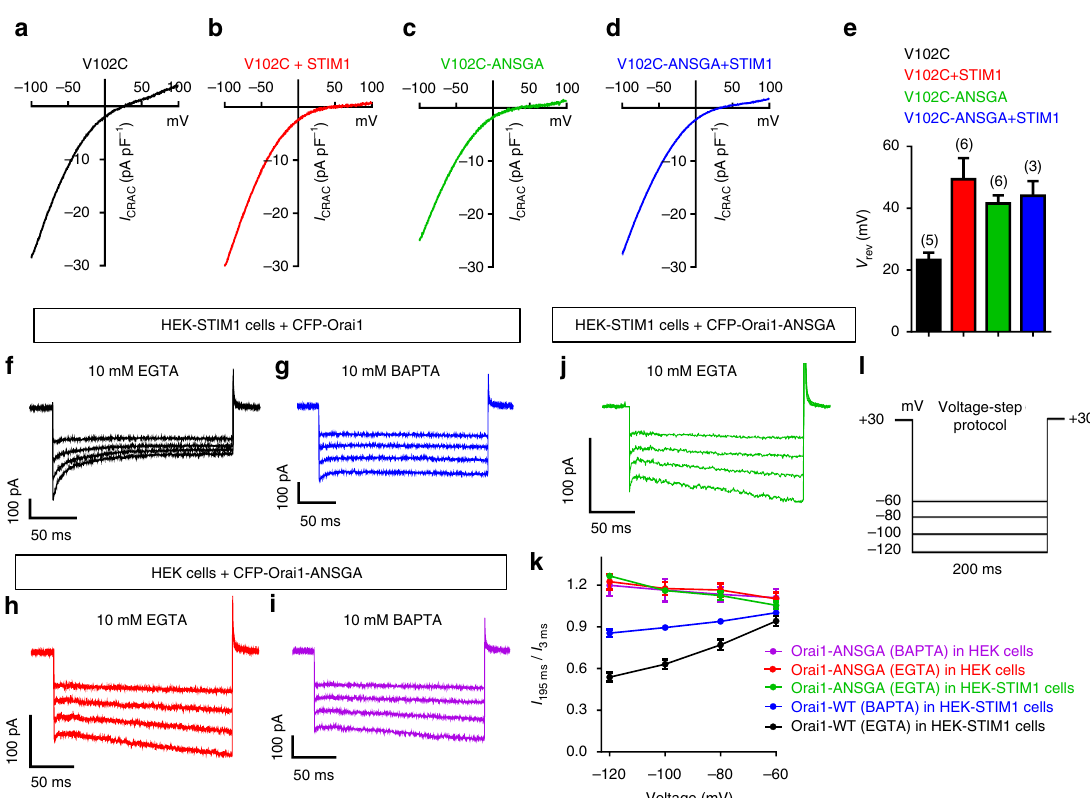
Figure 7 | The Orai-ANSGA mutation restores ion selectivity to the Orai1-V102C mutant and exhibits no CDI. ( a ) Current–voltage relationship for Orai1- V102C expressed in HEK cells (without STIM1 expression) with cytosolic Ca 2 þ buffered to 90nM with EGTA (stores replete), revealing a reversal potential of B 25mV reflecting the decreased Ca 2 þ selectivity of the pore mutant. ( b ) I – V for Orai1-V102C expressed in HEK-STIM1 cells with 10mM BAPTA in the pipette solution to deplete Ca 2 þ stores, revealing right-shifted reversal potential similar to WT Orai1. ( c ) I – V for the Orai1-V102C-ANSGA construct expressed in HEK cells without expressed STIM1 with Ca 2 þ buffered to 90nM (stores replete) as in a , revealing that the reversal potential is shifted right-ward similar to the shift induced by STIM1 and store emptying. ( d ) I – V for the Orai1-V102C-ANSGA expressed in HEK-STIM1 cells with 10mM BAPTA-induced store emptying, revealing that the right shift by ANSGA is not further altered by STIM1. ( e ) Summary of the reverse potential data